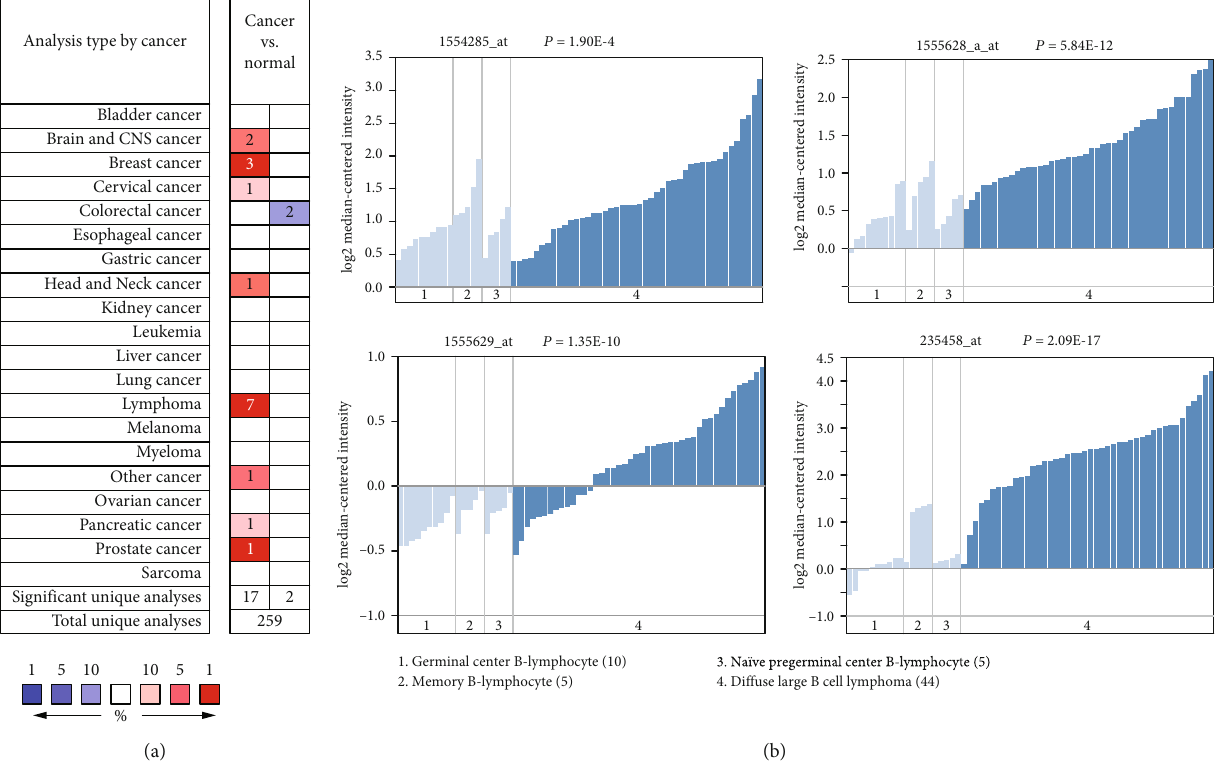
Figure 2: The mRNA levels of Tim-3 in tumor and normal tissues from the Oncomine database: (a) upregulation of Tim-3 was found in 8 of 20 cancer types, including lymphoma. (b) Tim-3 mRNA levels were signi fi cantly higher in DLBCL cells than normal B cells, including germinal center B-lymphocytes, memory B-lymphocytes, and naïve pregerminal center B-lymphocytes using four probes (1554285_at, 1555628_a_at, 1555629_at, and 235458_at) with the Compagno Lymphoma